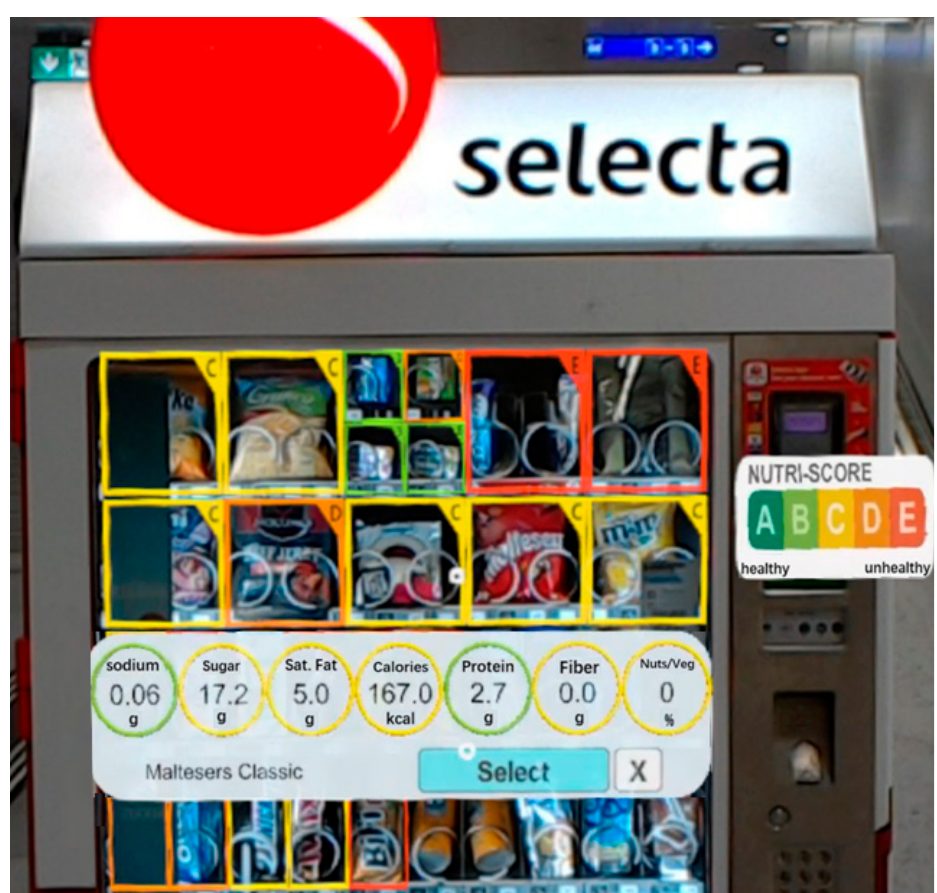
Figure 2. Detailed nutrition information of the selected snack displayed by the HoloLens. Reproduced from Fuchs et al. [23].